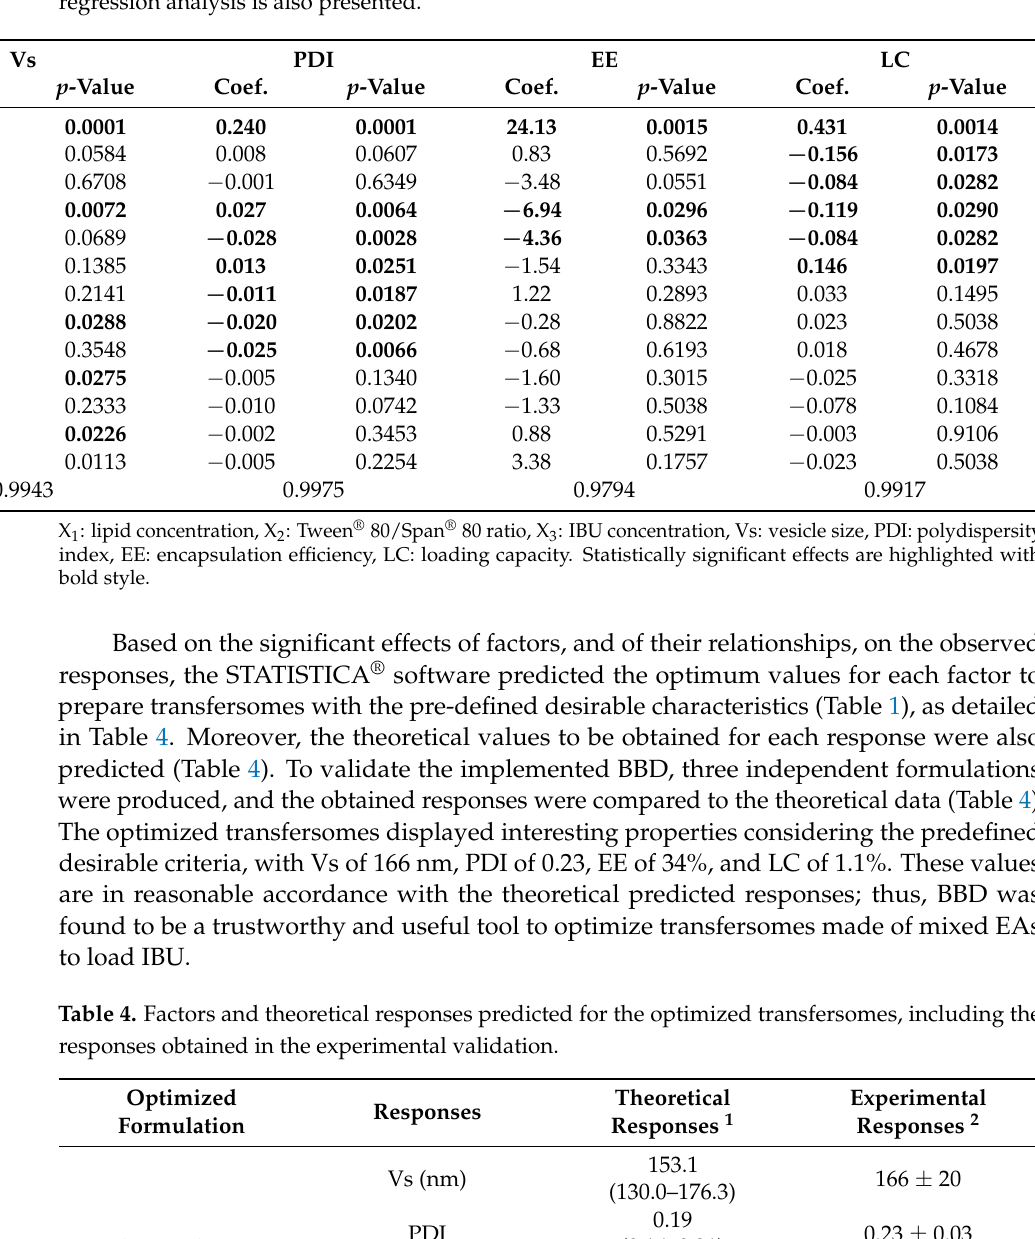
Table 3. Interaction coefficients (Coef.) and respective p -values obtained from the regression analyses performed using the two-way interaction (linear × quadratic) model to evaluate the impact of factors and their interactions on the observed responses. The coefficient of determination (R 2 ) of each regression analysis is also presented.